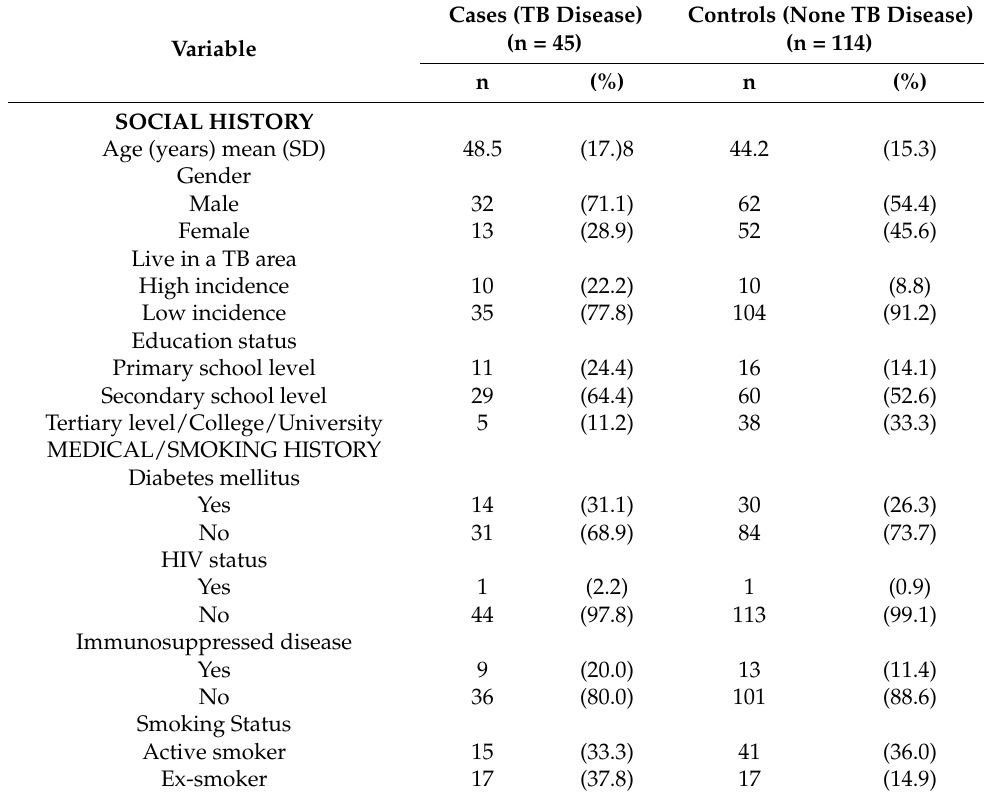
Table 1. Clinical characteristics of participants in Bachok, Kelantan (n = 159).